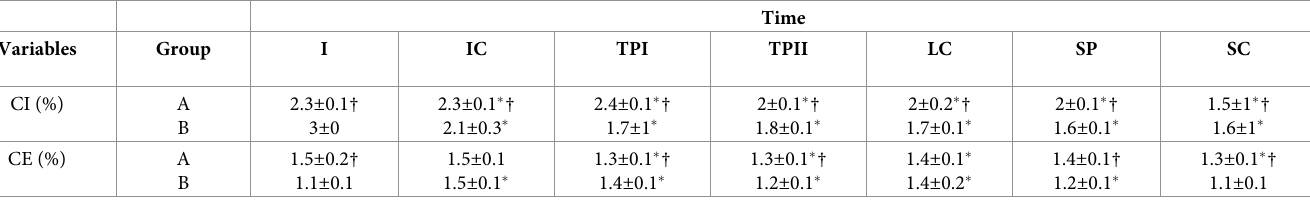
Table 2. Concentration of inspired (CI) and expired (CE) isoflurane.